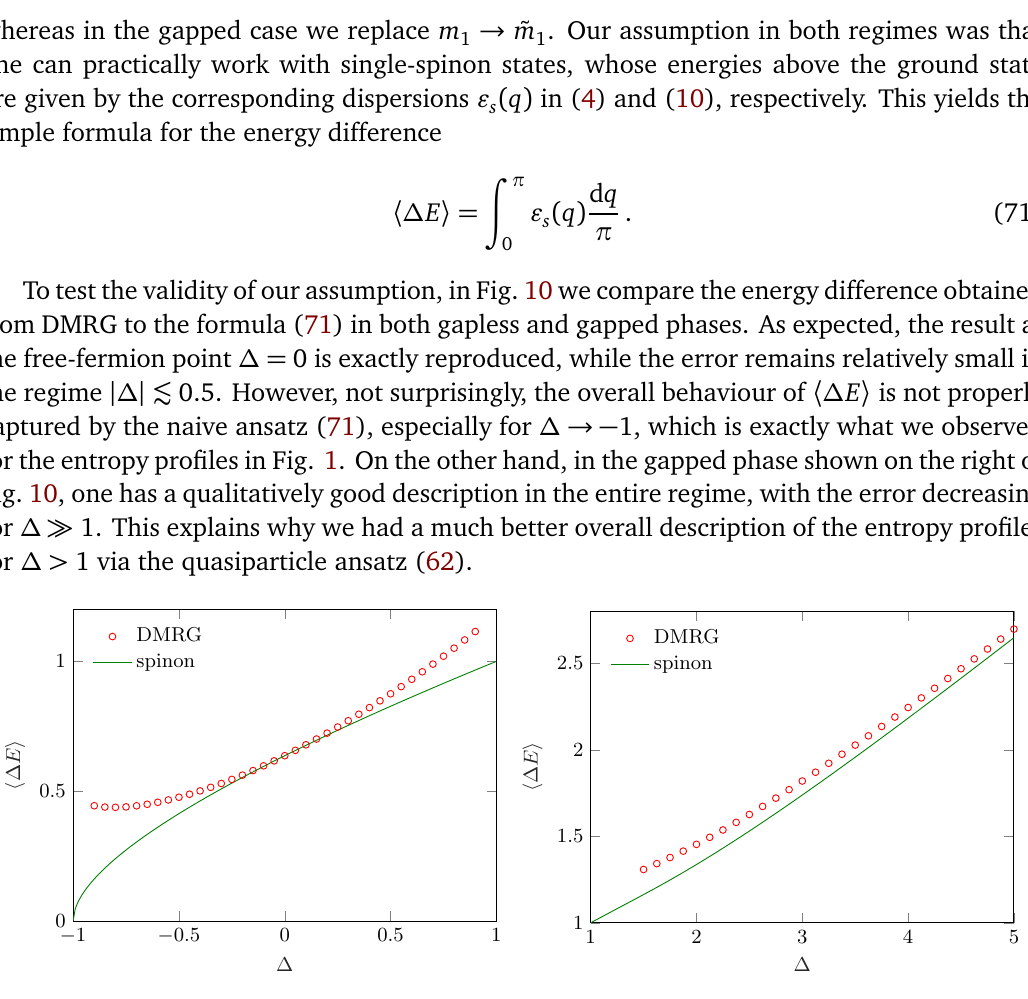
in the gapless 1